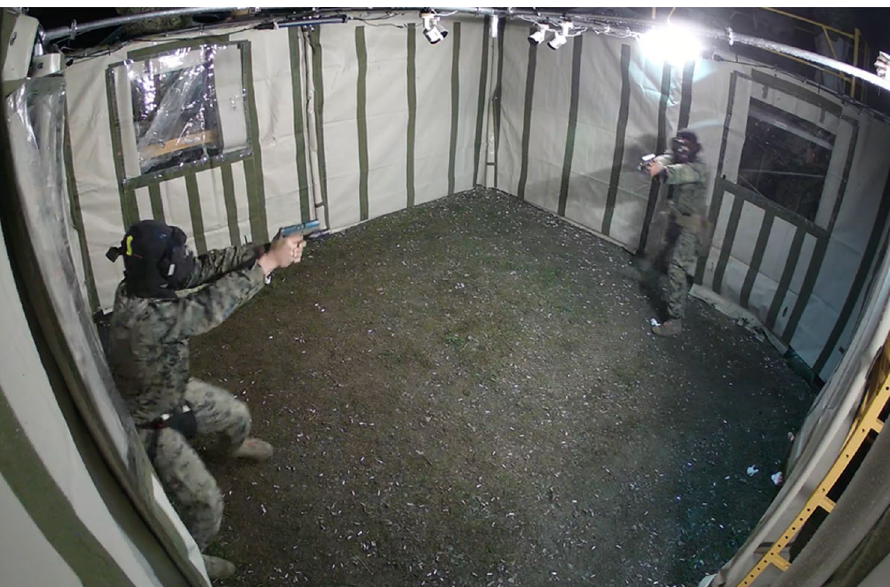
Figure 4. Sample image of the environment used during the force-on-force stress-inoculation training event against a single peer opponent. Participants were confined with a 4.9 m × 4.9 m space. Participants used pistols modified to fire non-lethal training ammunition and wore face, throat, and groin